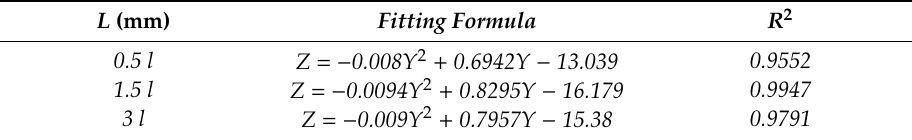
Table 4. Fitting formula of the annular gap flow velocity of the front pipe vehicle. L